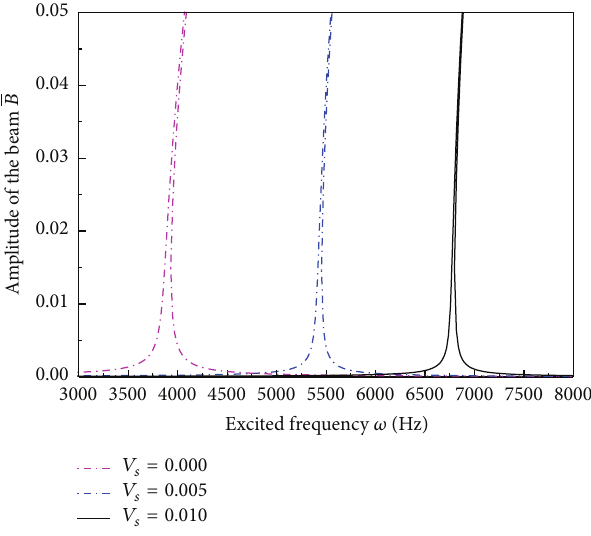
Figure 17: Amplitude 𝐵 versus frequency responses of the com- posite beams in the phase transformation state from martensite to austenite under the excitations for different 𝜀 0 ( T = 60 ∘ C, 𝑉 𝑠 = 0.005 , = 10 N, and 𝐿/ℎ = 10 ). 𝑞 0